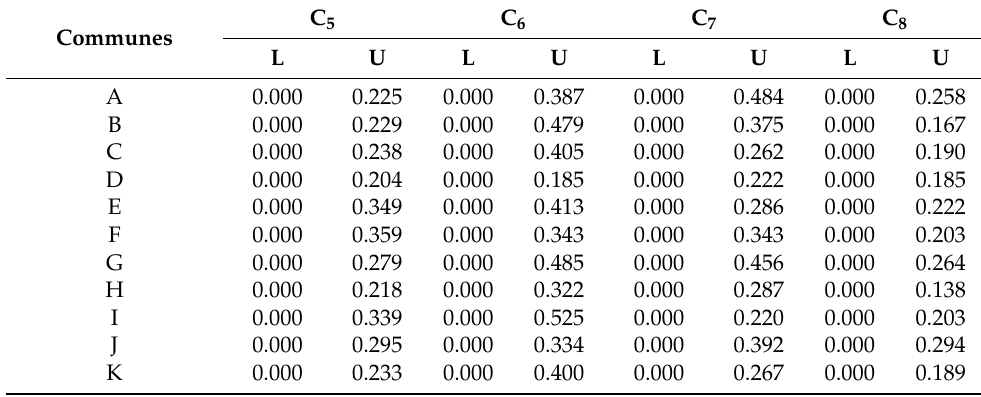
Table 10. Degrees of hesitancy in the form of intervals for criteria C 5 –C 8 .